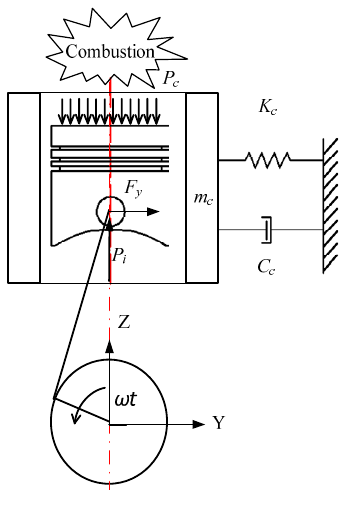
Figure 4. Dynamic model of cylinder assembly.